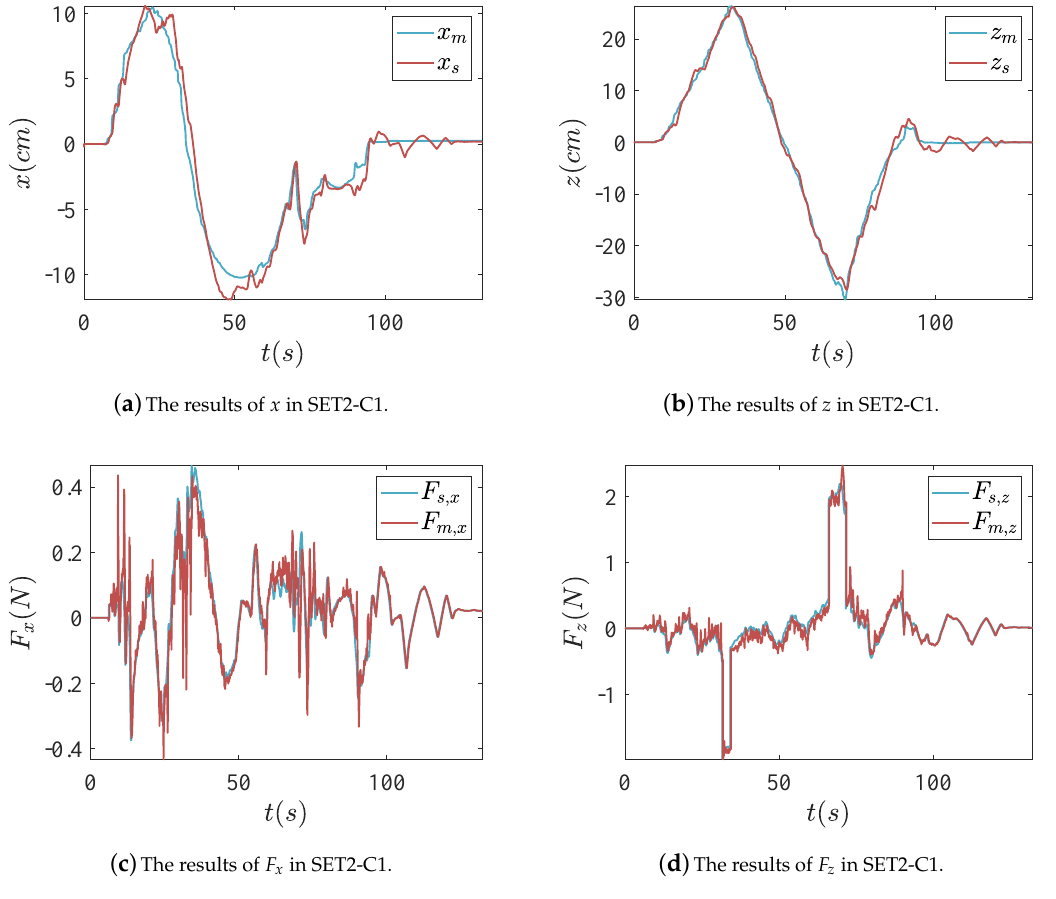
Figure 12. The results of